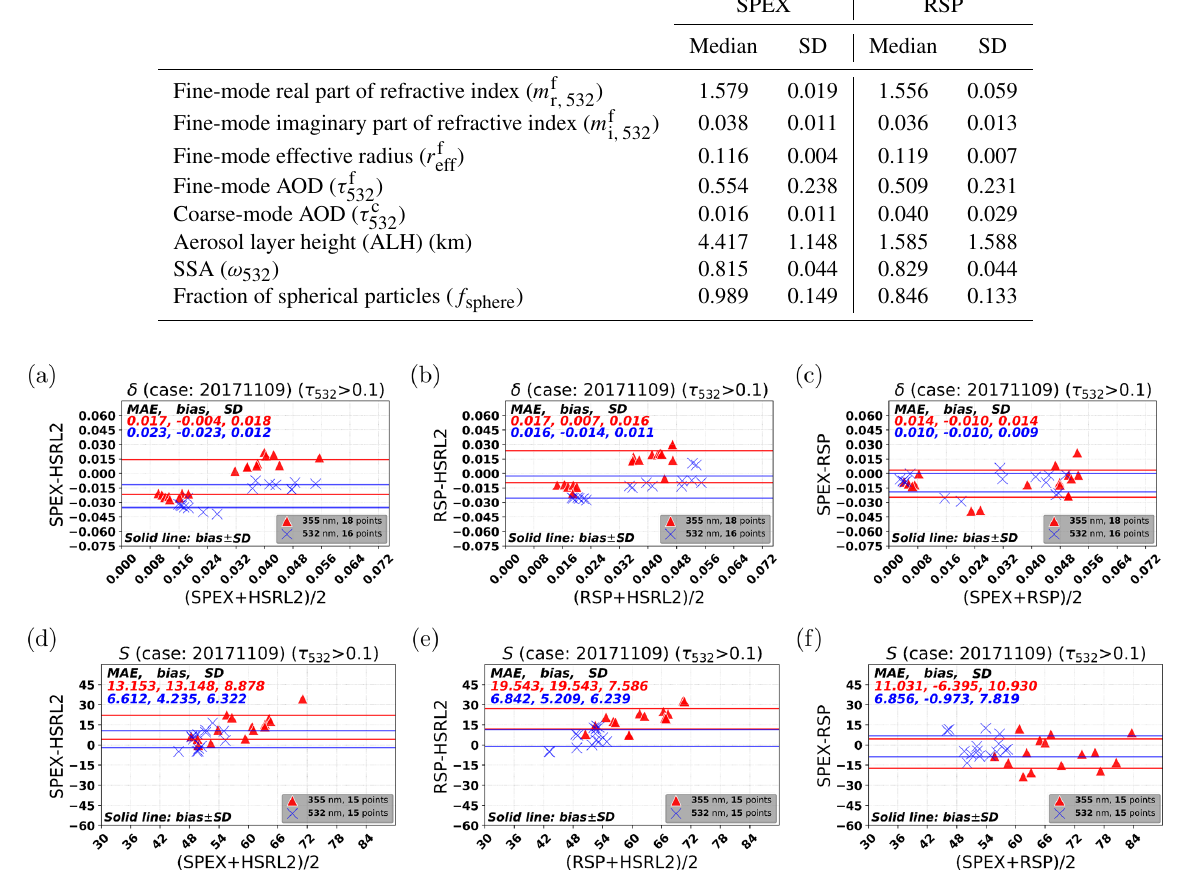
Figure 8. Comparison with HSRL-2 from 9 November 2017 (high AOD smoke case) for the aerosol depolarization ratio ( δ ) and the aerosol lidar ratio ( S ) between SPEX and RSP retrievals. (a) SPEX δ comparison with HSRL-2. (b) RSP δ comparison with HSRL-2. (c) SPEX δ comparison with RSP. (d) SPEX S comparison with HSRL-2. (e) RSP S comparison with HSRL-2. (f) SPEX S comparison with